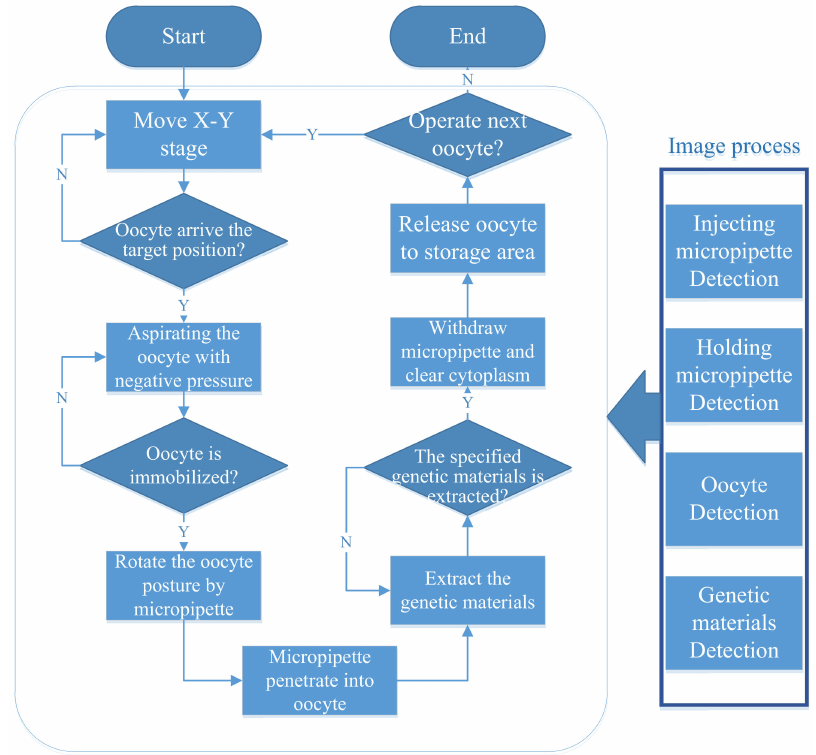
Figure 1. The process of robotic enucleation.